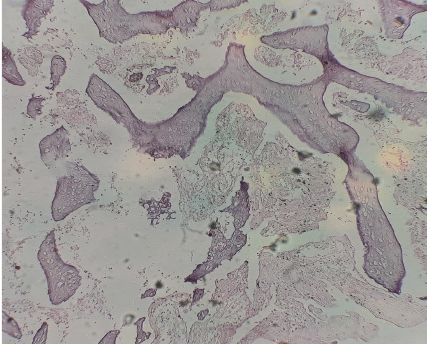
Figure 6: Osseous metaplasia. A histologic section of osseous metaplasia in a 29-year-old woman with primary infertility and history of missed